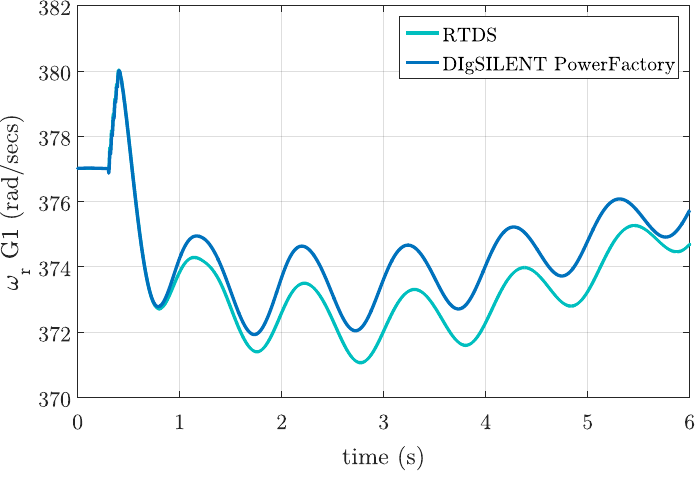
Figure 5. Rotor speed comparison between two professional